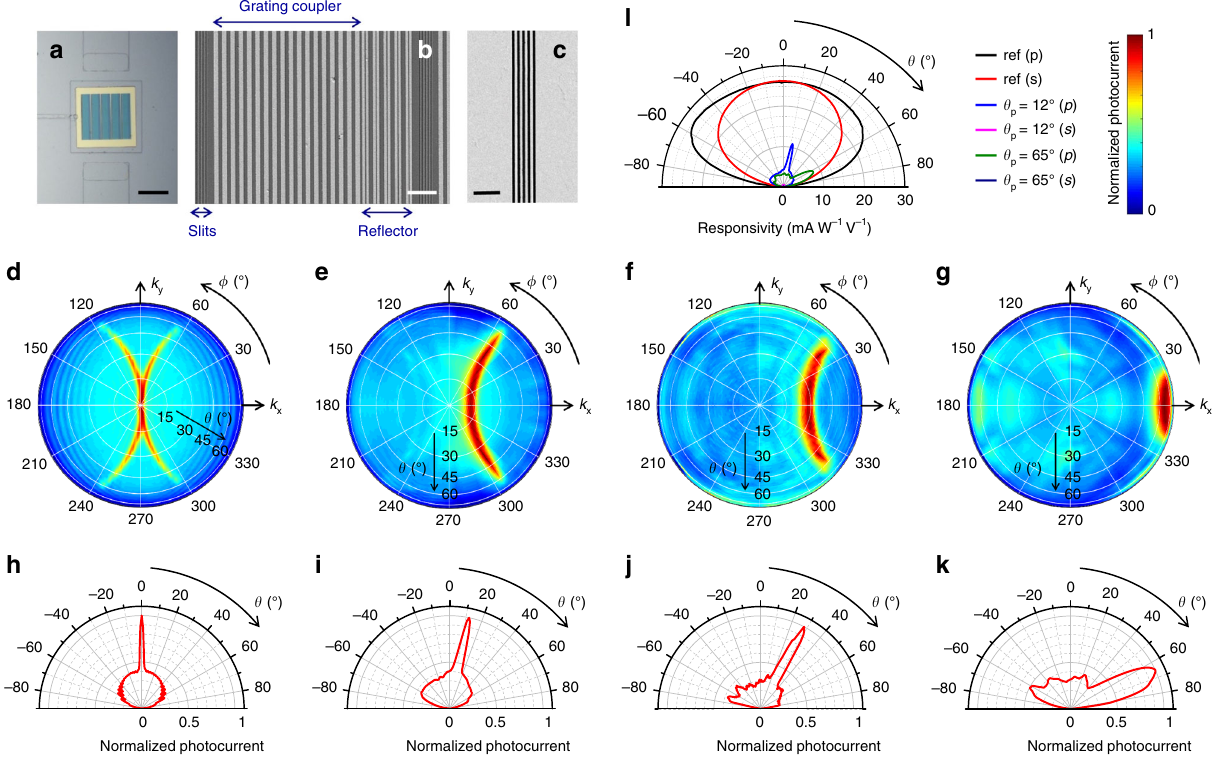
Fig. 3 Measurement results. a – c Optical ( a ) and SEM ( b , c ) images of representative experimental samples. The scale bar is 100 μ m in a , 4 μ m in b , and 2 μ m in c . In a the entire metasurface of a complete device is seen through a Ti window covering the entire sample, which is introduced to avoid spurious photocurrent signals. The image of c was taken before fabrication of the NP array. d – g Measured angular dependence of the photocurrent of four devices based on the structures of Fig. 2, providing peak response near θ p = 0° ( d ), 12° ( e ), 28° ( f ), and 65° ( g ). In each plot, the photocurrent is normalized to the peak value. SEM images reveal some deviations in the array periods and NP widths from their target design values. The measured values are Λ = 1440, 1180, 1030, and 775 nm and w = 240, 560, 526, and 256 nm for the devices of panels d , e , f , and g , respectively. h – k Line scans along the ϕ = 0° direction from the maps of d – g , respectively. l p - (i.e., xz -) and s - (i.e., yz -) polarized responsivity versus polar angle of incidence on the x – z plane, measured with three different samples: a reference device without any metal fi lm and NP array, and two metasurface-coated devices providing peak detection at θ p = 12° and 65°, respectively. Source data for panels d – g are provided as Source Data fi